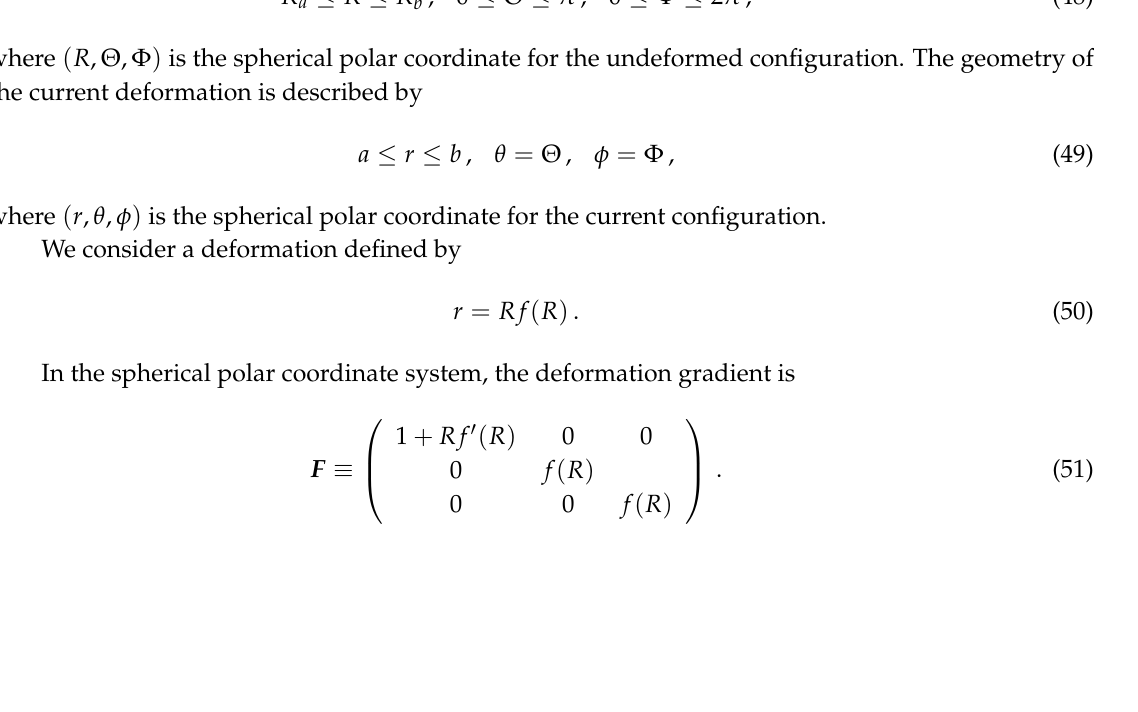
Figure 3. σ rr and σ θθ stress fields along the radius R . ¯ α =